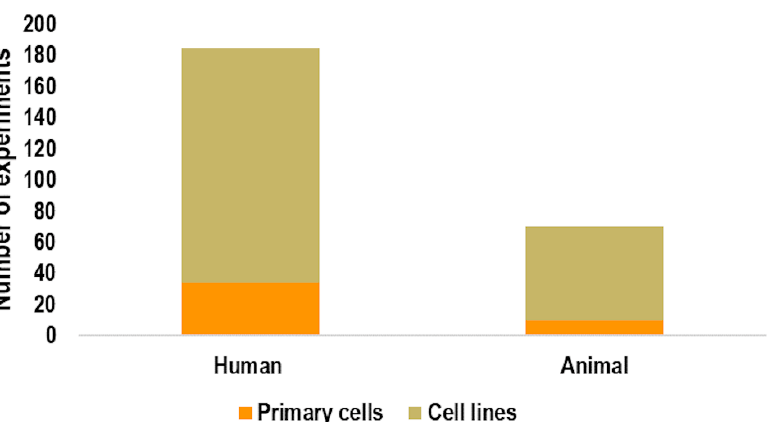
Figure 4. Number of experiments using animal or human cells. For each group, the number of experiments using primary cells vs. cell lines is also reported.